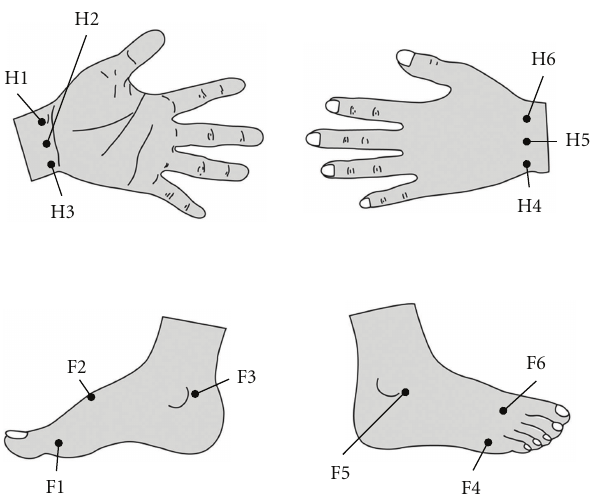
Figure 2: According to the traditional Chinese meridian theory, there are 6 acupoints on each limb (both right and left limbs are symmetric). H1: lung; H2: pericardium; H3: heart; H4: